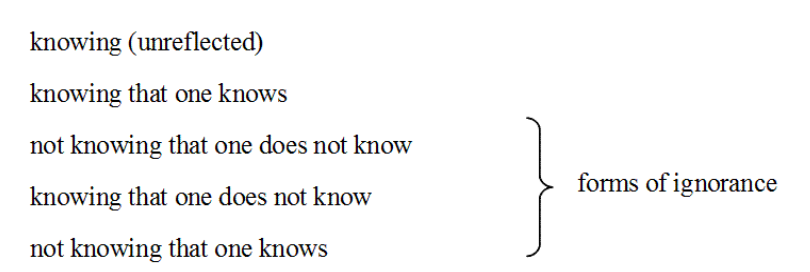
Figure 1. Forms of